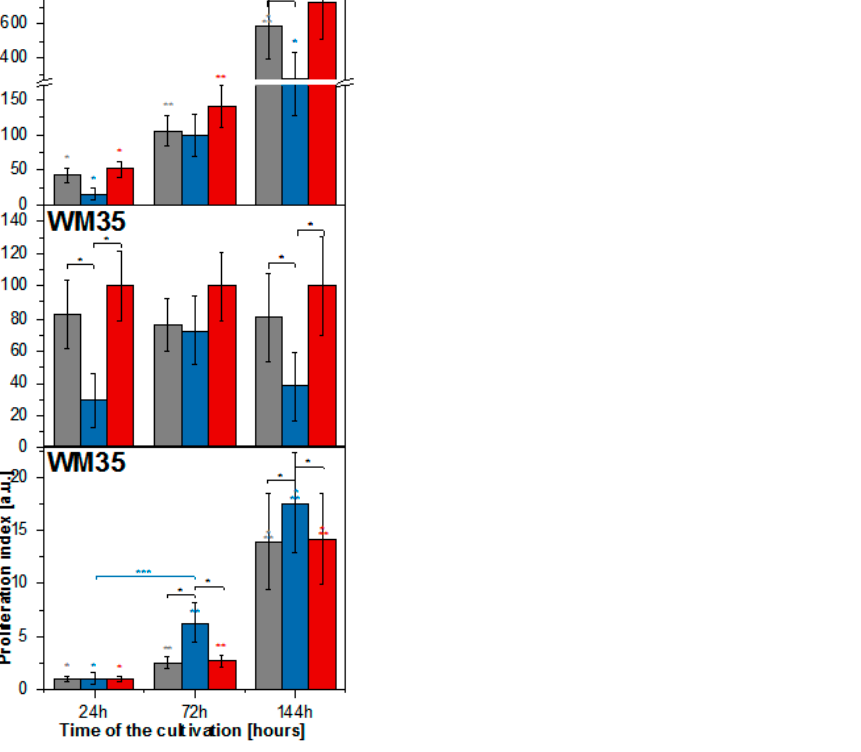
Figure 10. Impact of glass surface, POEGMA and POEGMA-grafted brush coatings with incorporated CaCO 3 NPs on the amount ( a ), viability ( b ) and proliferation index ( c ) of WM35 cells (*, **, *** significantly different from each other, p < 0.05). Data are presented as a mean ± standard deviation (SD) from n = 10 repetitions.